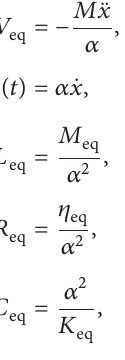
mechanical model involving mass ( 𝑀 eq ), damping ( 𝜂 eq ), spring ( 𝐾 eq ), and piezoelectric unit as shown in Figure